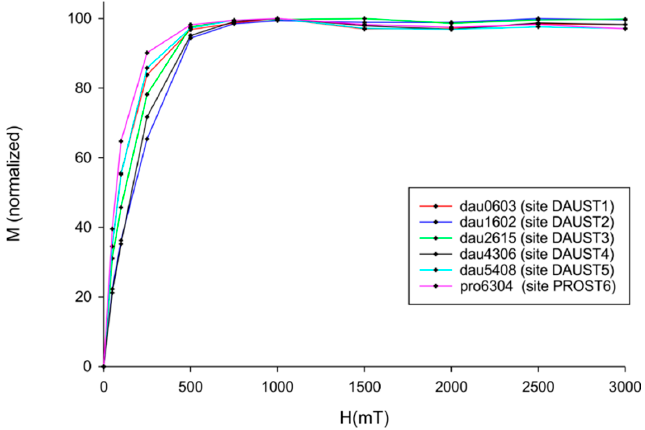
Figure 8. Results of isothermal remanent magnetization (IRM) acquisition curves experiments of metadolerites from SW Oscar II Land.